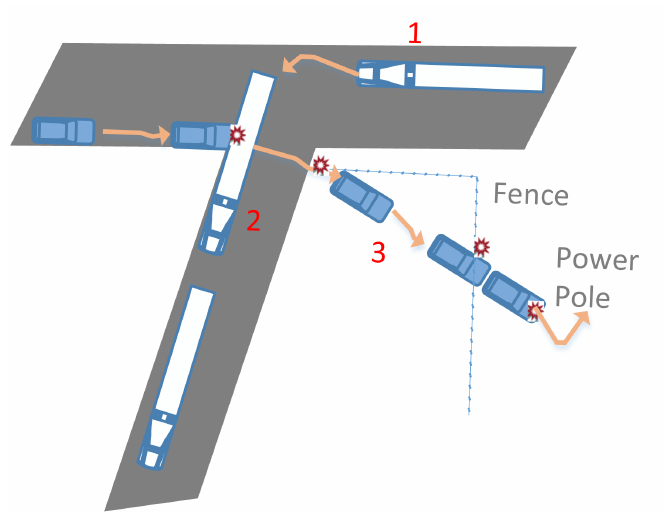
Figure 15. Impact and final location of the